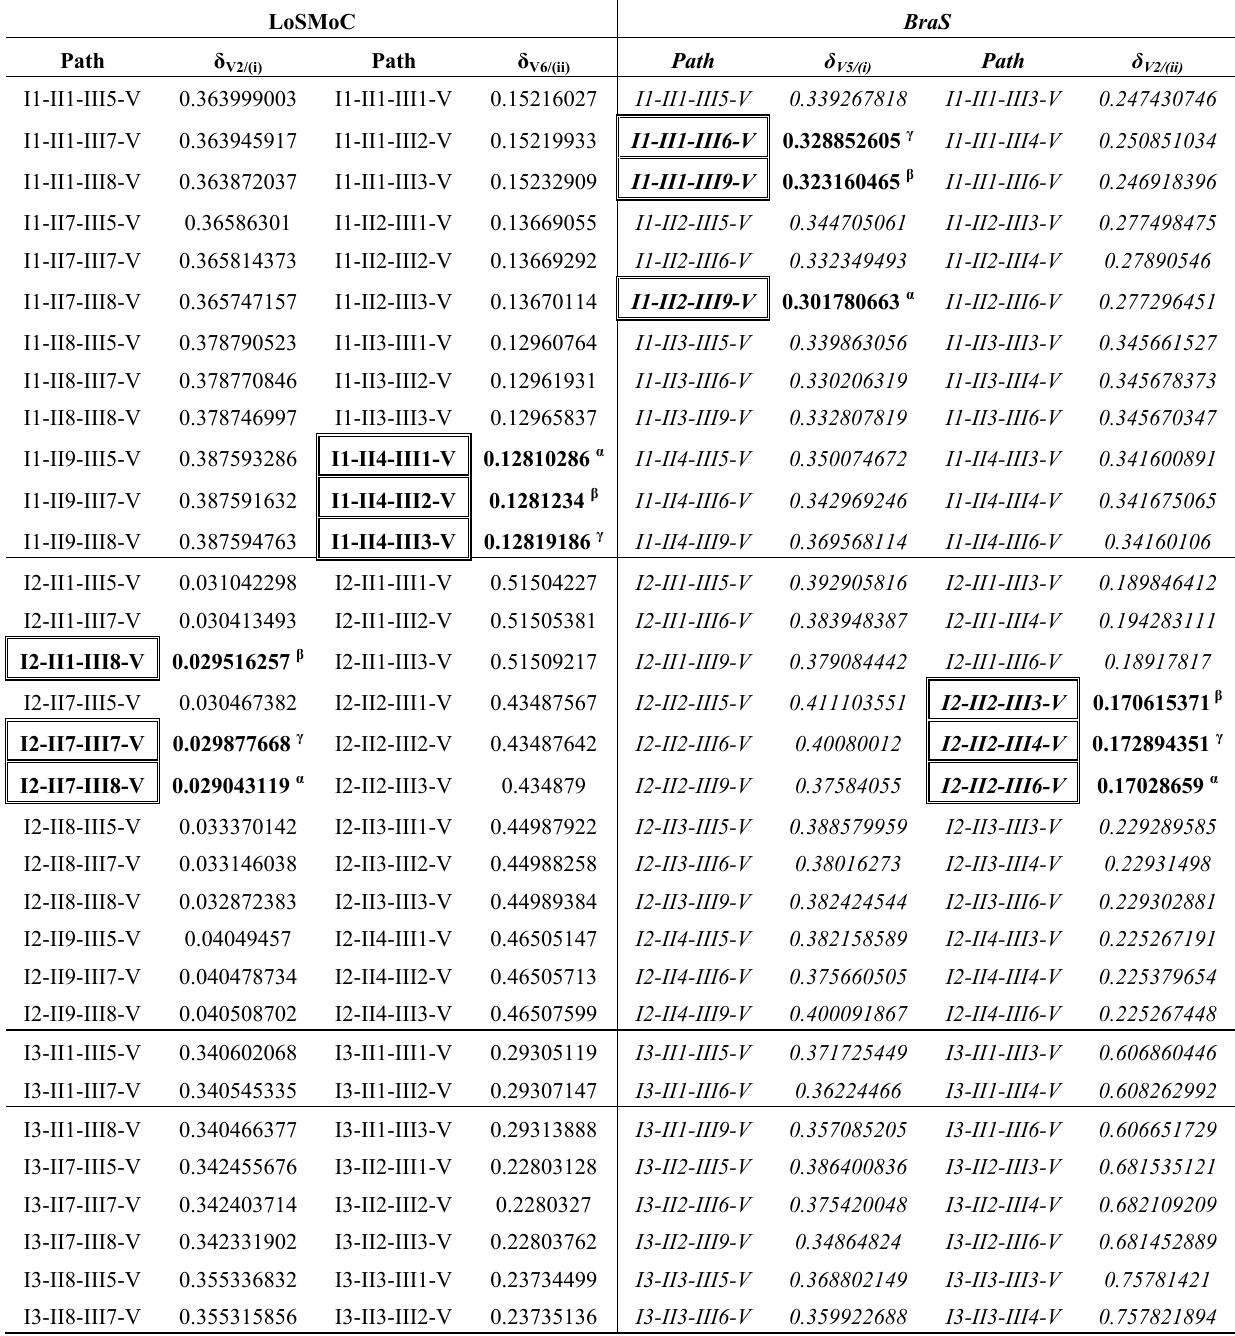
Table 5. Endpoint paths and their lengths ( δ ) considered for the best/relevant QSAR’s correlations’ models of Table 4, in cases V2/(i) and V6/(ii) for longest SMILES molecular chain (LoSMoC) and in cases V5/(i) and V2/(ii) for branching SMILES (BraS) selected compounds’ sets from Table 3, upon the Euclidian metrics of Equation (17) applied on the first four shortest intermediary QSAR models of Table 4; the overall first three shortest path- lengths are identified in each configuration case by bolding and labeling as alpha ( α ), beta ( β ) and gamma ( γ ) superscripts,